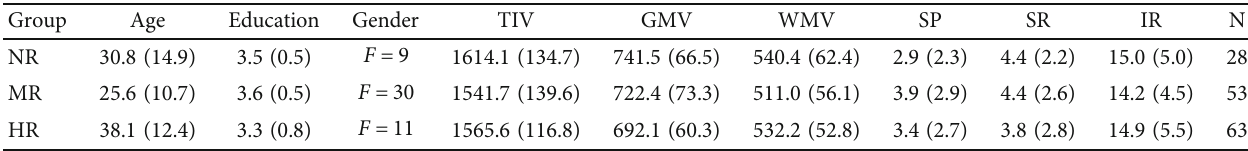
Table 1: Means and standard deviations for age, education level, number of women, total intracranial volume, total gray and white matter volumes, punishment and reward sensitivity, and preference for immediate rewards in each group.